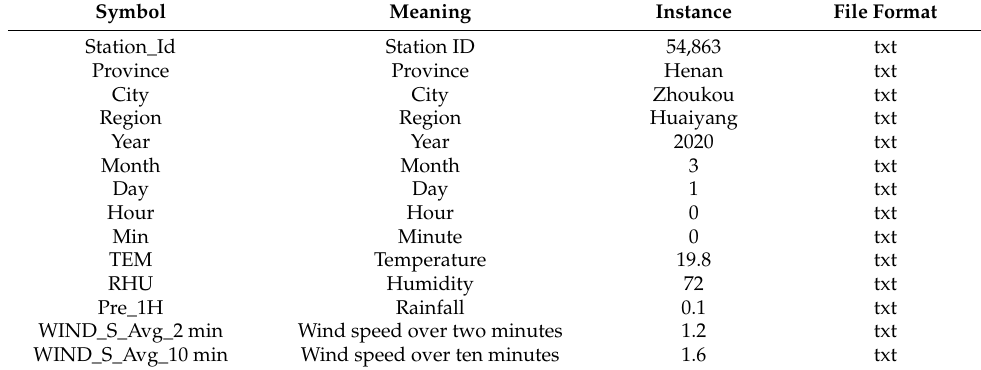
Table 2. Definition of the China